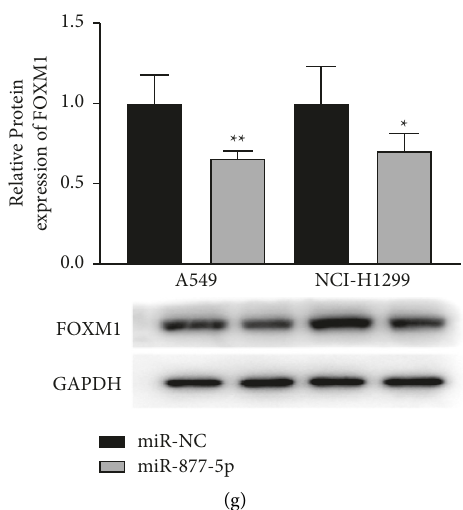
Figure 3: FOXM1 is a direct downstream gene of miR-877-5p. (a) The predicted binding sequence of miR-877-5p and FOXM1. (b) Luciferase reporter assay was conducted to verify the relationship between miR-877-5p and FOXM1. (c) Expression levels of FOXM1 were detected in cells. (d) The mRNA levels of FOXM1 in tissues. (e) Spearman’s correlation scatter plot. r �− 0.3463, P � 0 . 0375. The mRNA (f) and protein (g) expression of FOXM1 in A549 and NCI-H1299 cells. ∗ P < 0 . 05, ∗∗ P < 0 . 01, ∗∗∗ P < 0 . 001, and ∗∗∗∗ P < 0 . 0001.